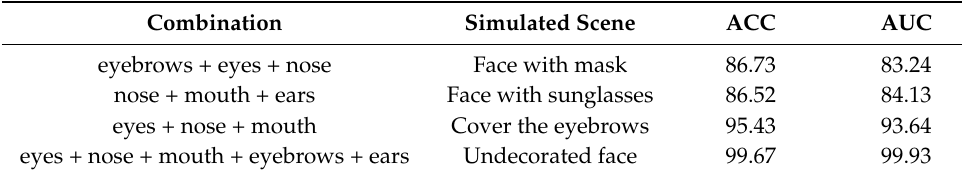
Table 1. Results of key-organ ablation